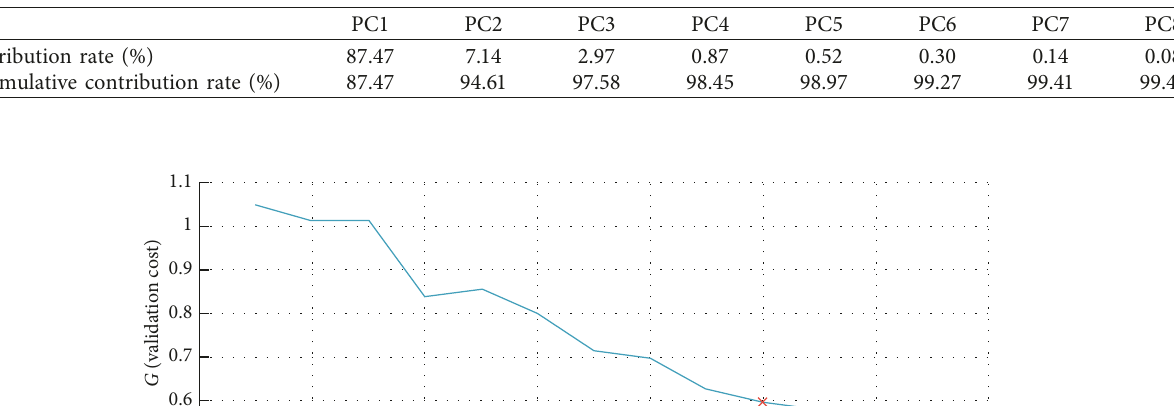
Table 2: The contribution and accumulative contribution rates of the first 8 PCs of the spectra.